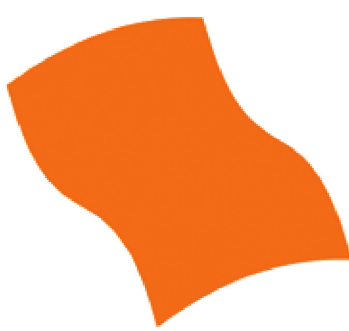
Figure 3: Explicit surface 2.